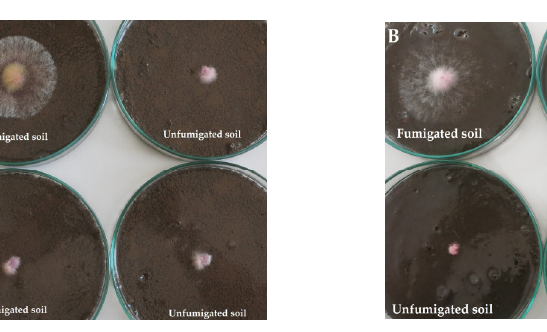
Figure 2. F. graminearum growth after 4 days post-inoculation with mycelial plug (Ø 8) mm and incubation in the dark at 22 °C on the fumigated (left upper plate) and unfumigated soil collected from ( A ) conventional tillage, ( B ) reduced tillage and ( C ) no-tillage systems. Table 2. Comparison of the soil fungistasis (%) against F. graminearum growth depending on the tillage practice (Factor A) and the soil sampling time (Factor B), obtained by two-way ANOVA and Tukey’s mean separation tests.